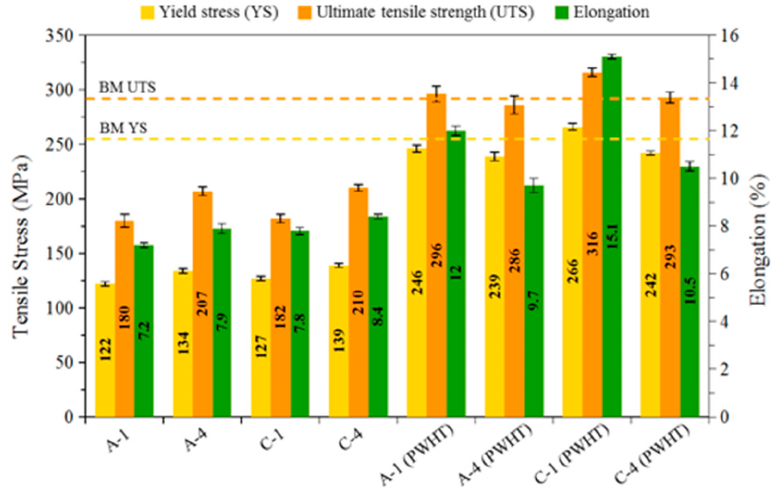
Figure 10. Effects of PWHT on the tensile properties of FSW Al6061(T6). Figure 10. E ff ects of PWHT on the tensile properties of FSW